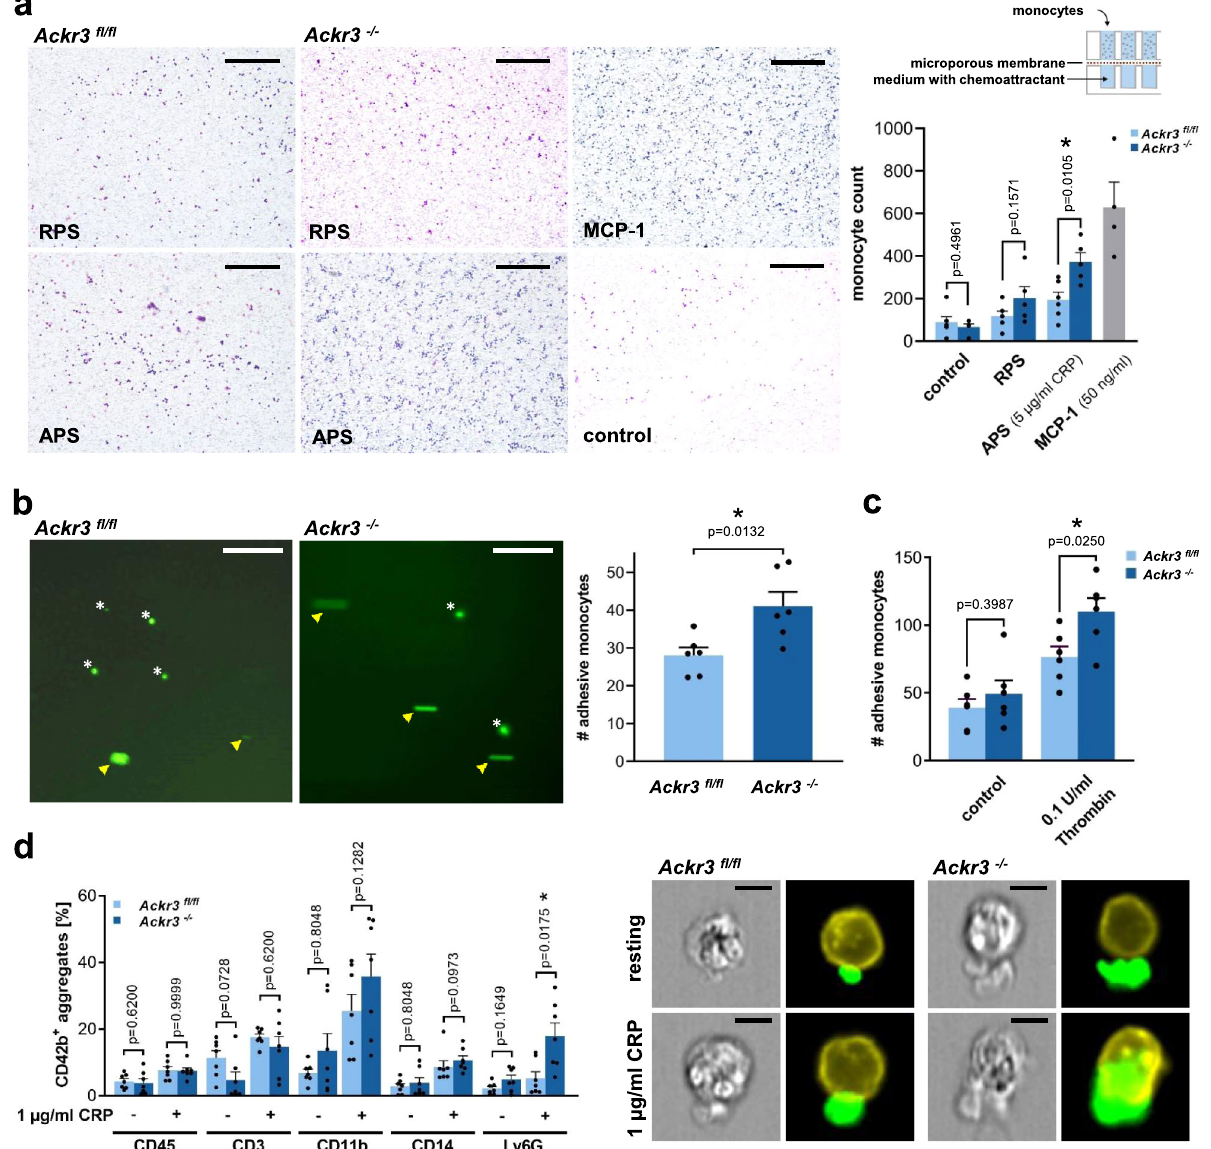
Fig. 4 Ackr3 − / − platelets promote thrombo-in fl ammation in vitro. a Schematic drawing of a modi fi ed Boyden chamber used for the following experiments and representative images (scale bar = 200 µ m). Statistical analysis of the monocyte migration toward RPS and APS (5 µ g/ml CRP-XL) derived from Ackr3 − / − or Ackr3 flfl . The migration of monocytes was enhanced towards APS derived from Ackr3 − / − platelets compared to Ackr3 fl / fl APS. 50 ng/ml MCP-1 was used as a positive control. Ackr3 fl / fl n = 6, Ackr3 − / − n = 5; MCP-1 n = 4; Plotted: mean ± S.E.M.; statistics: Student ’ s t test (two- tailed); 95% con fi dence interval. b Representative images of fl ow chamber experiments were performed with isolated human monocytes. The monocytes were perfused over Ackr3 fl / fl (left panel) and Ackr3 − / − (right panel) platelets spread (1 µ g/ml CRP) on fi brinogen-coated cover slides. Yellow arrowheads point at rolling monocytes whereas asterisks indicate adhesive monocytes (scale bar = 100 µ m). Statistical analysis of the number of rolling monocytes within 40 s of perfusion. An enhanced adhesion between Ackr3 − / − platelets and human monocytes compared to Ackr3 fl / fl platelets was observed, n = 6; Plotted: mean ± S.E.M.; statistics: two-tailed Student ’ s t test; 95% con fi dence interval. c Statistical analysis of the static adhesion of Ackr3 − / − platelets to murine monocytes compared to wild-type control platelets after 2 h incubation period. An enhanced adhesion between Ackr3 − / − platelets and murine monocytes was observed compared to Ackr3 fl / fl platelets after thrombin (0.1 U/ml) stimulation, n = 6; Plotted: mean ± S.E.M.; statistics: Student ’ s t test (two-tailed); 95% con fi dence interval. d Statistical analysis of the spontaneous co-aggregate formation of Ackr3 fl / fl and Ackr3 − / − platelets measured by fl ow cytometry analysis under unstimulated and stimulated conditions (1 µ g/ml CRP-XL). Image stream images from Ly6G + /platelet aggregates, n = 7; Plotted: mean ± S.E.M.; statistics: two-tailed Mann – Whitney U